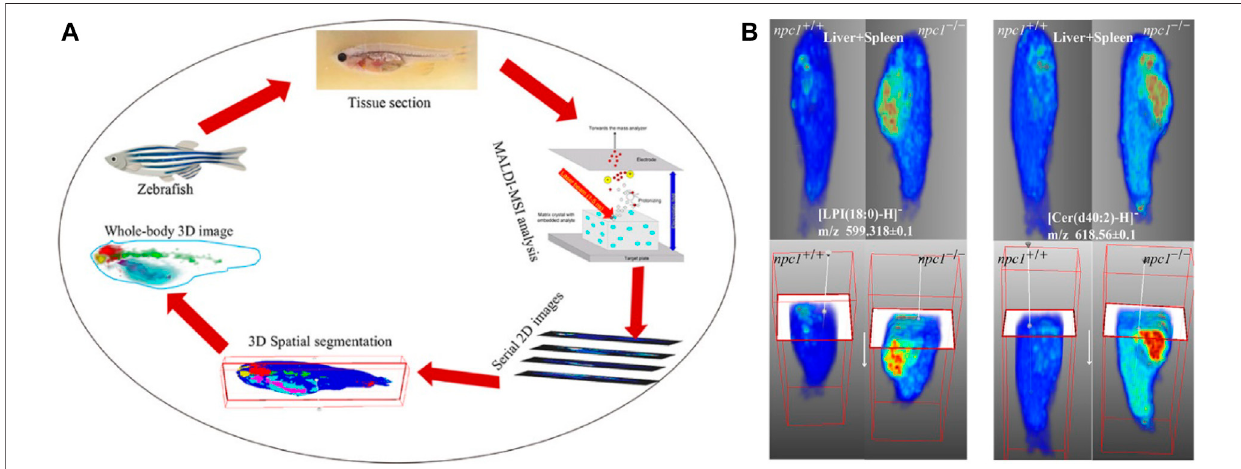
FIGURE 10 | Three dimensional (3D) reconstruction of zebra fi sh by MALDI-MSI (Liang et al., 2021). (A) The work fl ow of the 3D MALDI-MSI method. (B) Spatial distributions of Cer (d34:1) and Cer (d37:1) in fi sh brain.